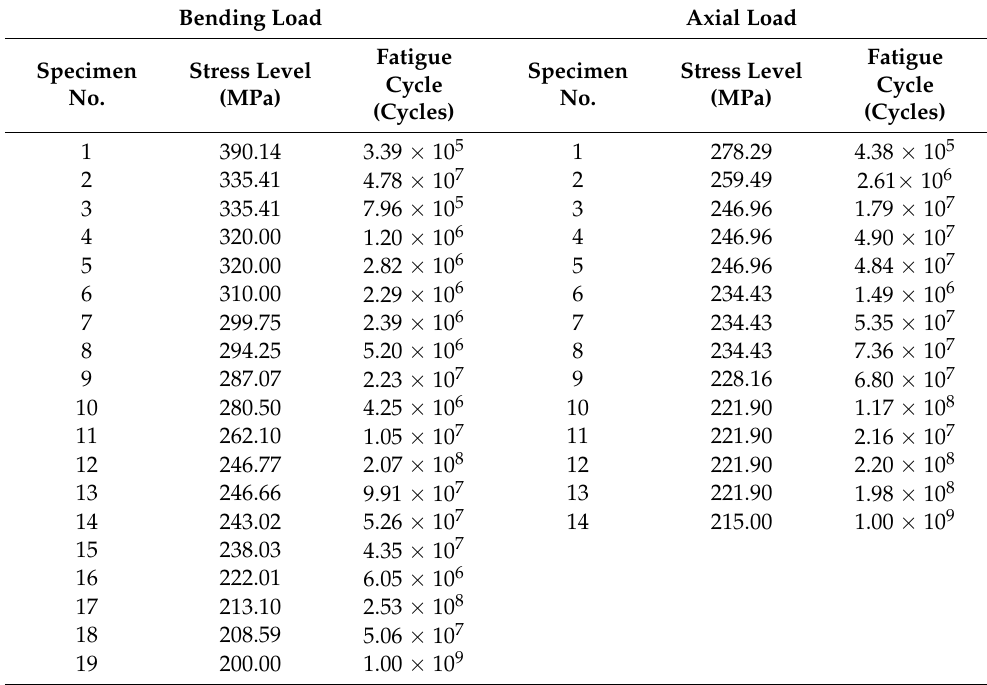
Table 2. S-N original data of bending and axial loading